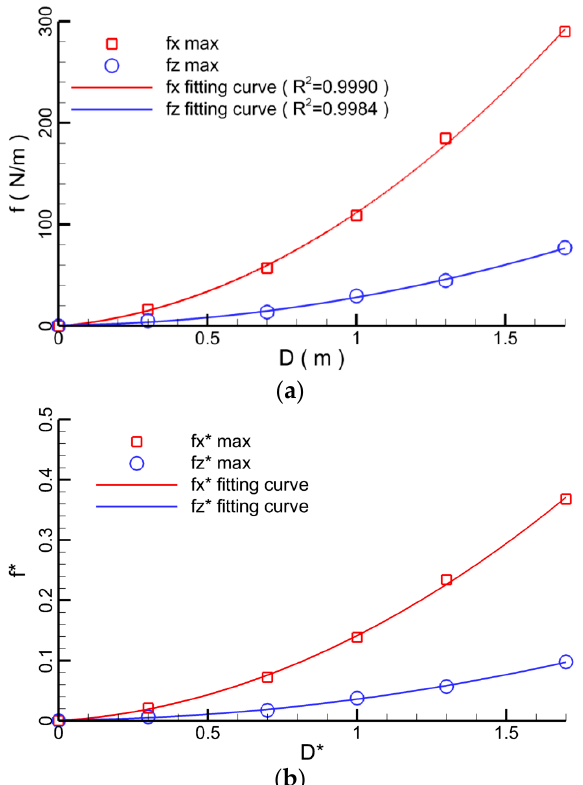
Figure 15. The maximum hydrodynamic forces at different pipelines. ( a ) Maximum force. ( b ) Non-dimensional maximum force.